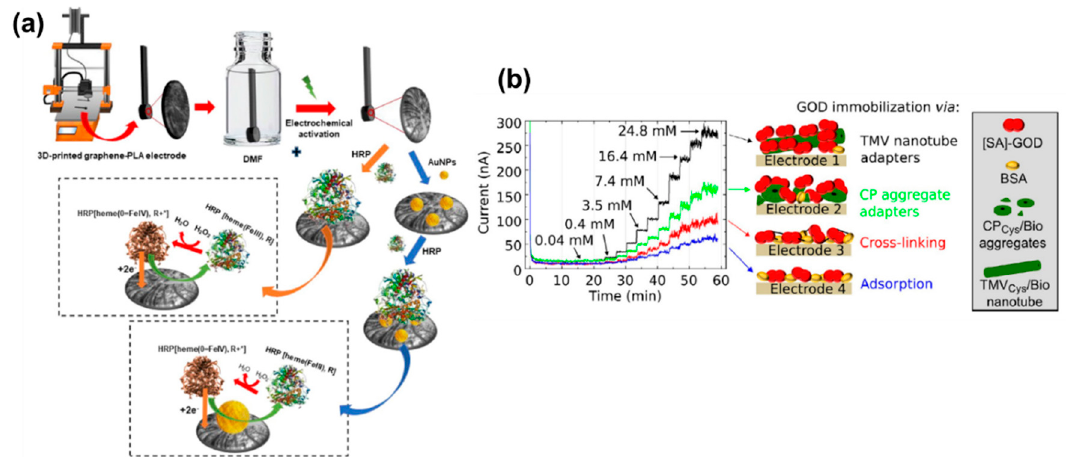
Figure 3. ECBs for H 2 O 2 and glucose detection. ( a ) Fabrication of the screen printed H 2 O 2 sensor and H 2 O 2 detection mechanism through interaction with the horseradish peroxidase (HRP) enzyme [62]. ( b ) Amperometric response for different modifications of the electrochemical glucose biosensors [63]. Reprinted with permission from [62,63], Copyright © 2020 and 2019 Published by Elsevier B.V. DMF: Dimethylformamide, GOD: Glucose oxidase, CP: Coat proteins, TMV: Tobacco mosaic virus, BSA: Bovine serum albumin.